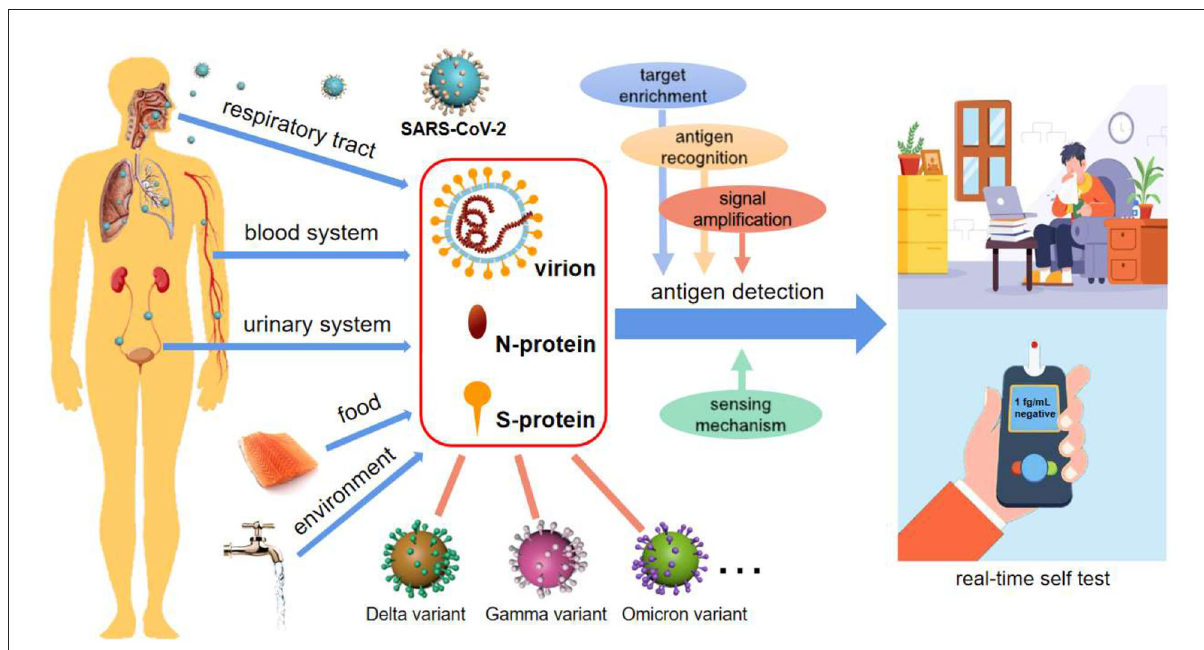
FIGURE1 SARS-CoV-2 diagnosis via antigen test. Antigen detection toward POCTs commonly uses virion, N-protein, and S-protein as targets, potentially integrating with target enrichment, antigen recognition, signal amplification as well as innovative sensing mechanisms. Antigen-based detection strategies may be applicable for various types of body fluids, food, and environmental samples, and are broad-spectrum for SARS-CoV-2 variant recognition. It is also an enabler of real-time self-tests for infectious